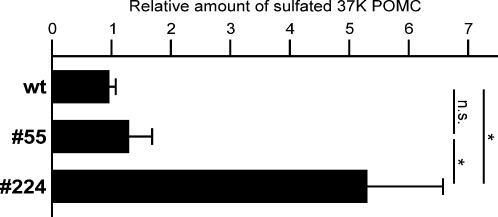
Sulfation of newly synthesized POMC in wild-type and transgenic Xenopus intermediate pituitary cells.Neurointermediate lobes (NILs) from wild-type frogs (wt) and frogs transgenic for p24α3 (#55) or p24δ2 (#224) were pulse labeled with 35S-sulfate and 3H-lysine for 15 min. Newly synthesized proteins extracted from the NILs were resolved by 15% SDS-PAGE and the amount of [35S]SO4 and 3H-lysine incorporated into newly-synthesized 37K POMC was determined. Shown are the amounts of newly synthesized sulfated 37K POMC produced in the transgenic relative to wt NILs. Data are shown as means +/− SEM (wt, n = 7; transgenics, n = 5). *, p<0.05; n.s., not significant.